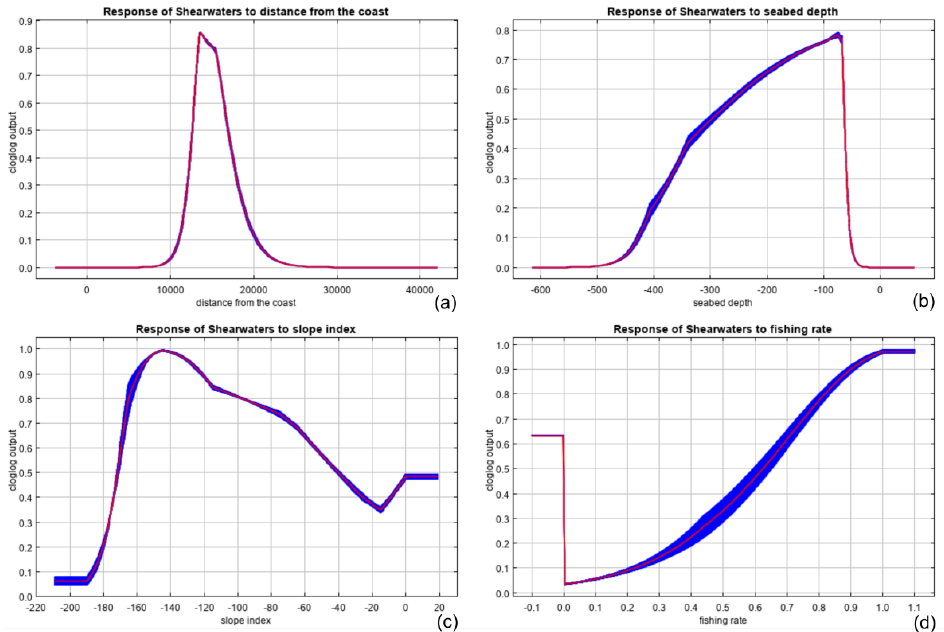
Figure 4. MaxEnt response curves for shearwaters, showing the probability of presence against each variable: distance from the coast (m) ( a ), seabed depth (m) ( b ), slope index (m) ( c ), and fishing rate ( d ).